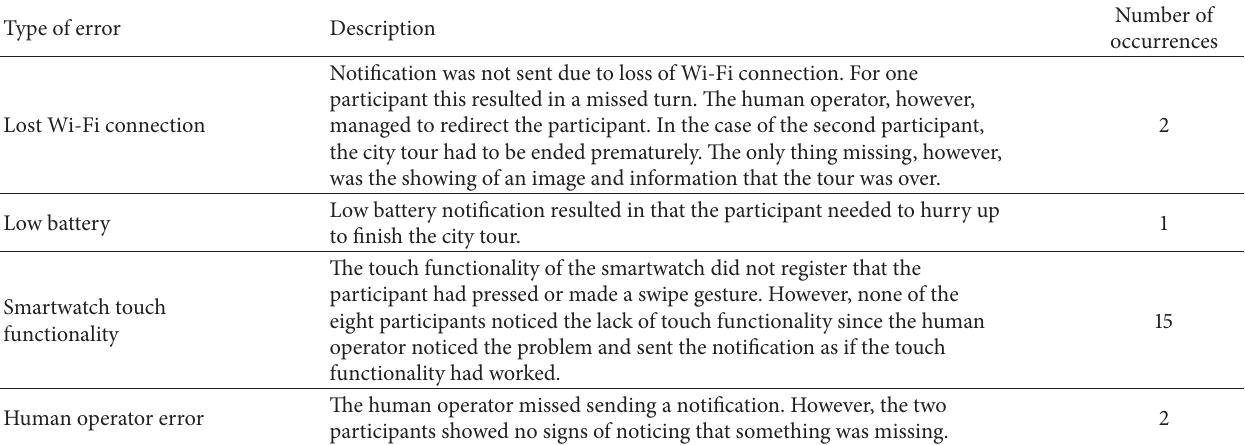
Table 3: Listing problems that occurred during the city tour.